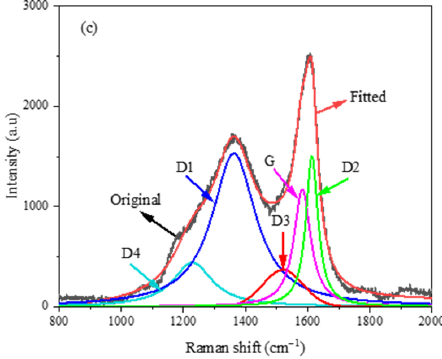
Figure 2. The curve fitting of Raman spectra of chars: ( a ) A600; ( b ) B600; ( c ) C600. Since the relative intensity of Raman spectra cannot fully represent the evolution of the structure, the band area of resolved peaks and band area ratios were used as Raman spectra parameters to characterize the change in carbonaceous structure in the study [35,36]. The various band area ratios and total band area are shown in Figure 3. It can be observed from Figure 3 that the values of A Total decreased significantly from 600 ◦ C to 900 ◦ C and then decreased slightly from 900 ◦ C to 1100 ◦ C. This shows that the macromolecules in coal chars went through condensation polymerization with the increasing temperatures. The band area ratios of A D1 / A G and A G / A Total are usually used to characterize the degree of order of coal chars [31,36]. These A D / A G parameters ( A D1 / A G , A D2 / A G , and A D3 / A G ) increased from 600 ◦ C to 900 ◦ C and then decreased from 900 ◦ C to 1100 ◦ C, as shown in Figure 3b–d. The dehydrogenation of hydroaromatics, the growth of aromatic rings, and the formation of a large number of defects and amorphous structures resulted in an increase in A D / A G [3,31]. The decrease in A D / A G parameters from 900 ◦ C to 1100 ◦ C indicated further ring condensation and the formation of additional large aromatic ring systems [37]. The variations of A D / A G parameters also indicated that the degree of order first decreased and then increased with increasing pyrolysis temperatures [35,38,39]. In contrast, the value of A G / A Total decreased from 600 ◦ C to 900 ◦ C and then increased from 900 ◦ C to 1100 ◦ C, as shown in Figure 3e. This suggests that the intercalation compounds and some polar groups inside the char were rapidly vaporized or broken down [40] and the macromolecules in coal chars went through subsequent graphitization with the increasing temperature [31].